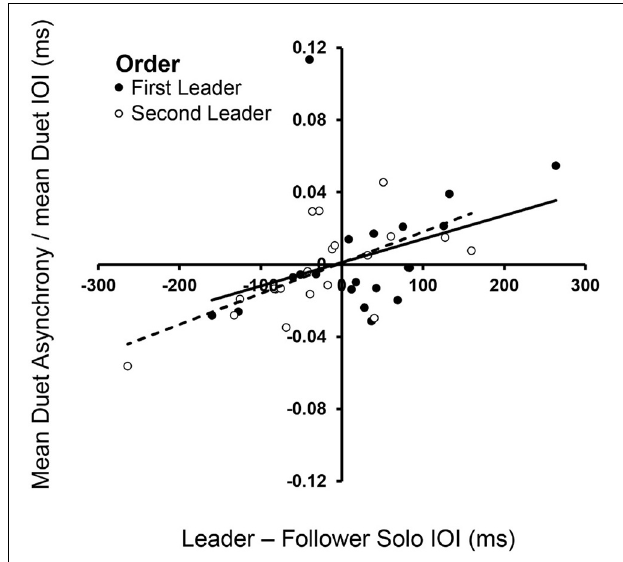
FIGURE 3 | Spontaneous frequencies in Solo performance influence Duet synchronization. Signed differences in partners’ mean Solo rates (Leader Solo mean IOI—Follower Solo mean IOI, x-axis) correlated with signed Duet tone onset asynchronies (Leader tone onset—Follower tone onset, divided by mean Duet performance rate) in First-Leader (black dots) and Second-Leader (white dots) conditions. Each dot represents data from one